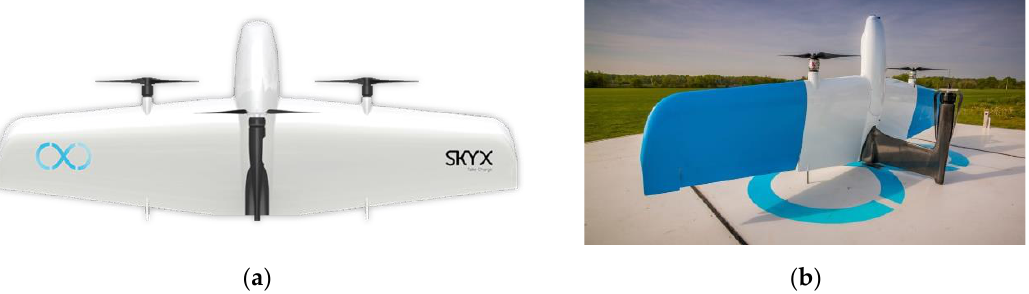
Figure 1. UAV SkyX [4]: ( a ) front view and ( b ) three-dimensional view.